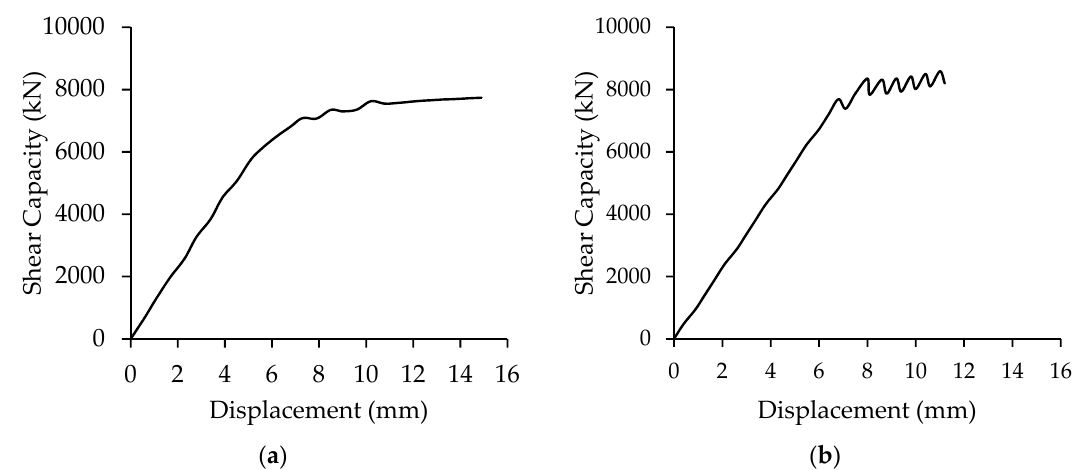
( b ) ( c ) Figure 8. Most vulnerable panels in Y ( a ) and X ( b ) direction; ( c ) C/D ratio for the most vulnerable panels. 5.4. The Nonlinear Analysis The seismic vulnerability evaluation of the case study was carried out also performing nonlinear static analyses by TREMURI software [10]. The FE model was loaded by gravity loads and then by monotonically increasing horizontal forces. It is worth underlining that a conventional pushover analysis, where the horizontal loads did not change with the analysis, was adopted. The pushover analysis was implemented considering two distributions of horizontal forces, i.e., proportional to the masses and proportional to the first vibration mode, applied at the level of floors